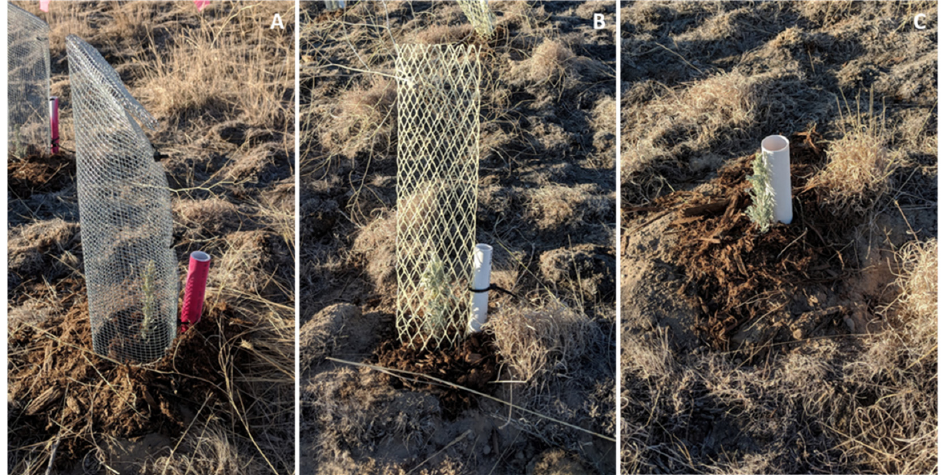
Figure 2. Seedlings after outplanting covered with a metal ( A ) or plastic ( B ) tree protector or without a protector ( C ).